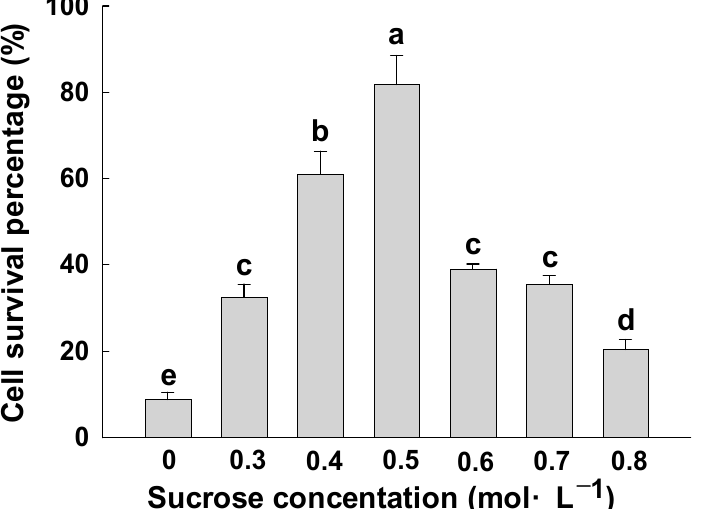
Figure 1. Effects of sucrose concentration on the cell survival of F. mandshurica EC after cryopreser- vation by vitrification. Note: Different letters are significantly different from each other at p < 0.05, using Duncan’s Multiple Range Test.